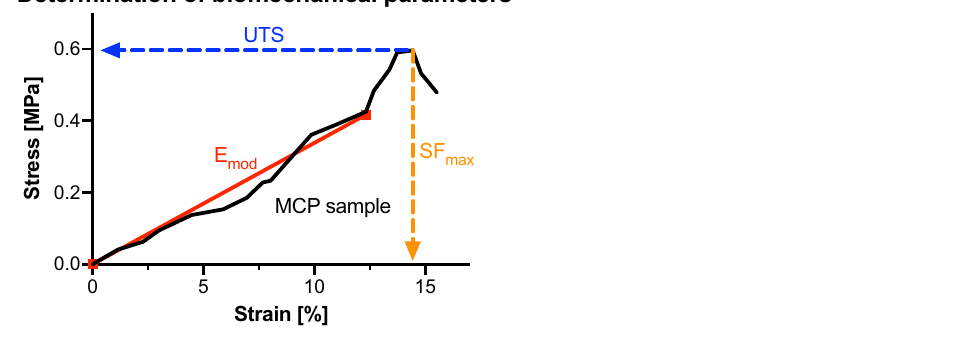
Figure 2. The determination of the biomechanical parameters in this study is shown representatively on a medial calcaneal periosteum (MCP) sample of this study. The elastic modulus (E mod ) was determined by a linear regression analysis between the zero-point and the point that equals 70% of the maximum stress. The ultimate tensile strength (UTS) equals the maximum stress (F max ) divided by the cross section value before the tissue failed when being stretched. The strain at maximum force (SF max ) reflects how much the sample was strained at the point of the UTS compared to its initial